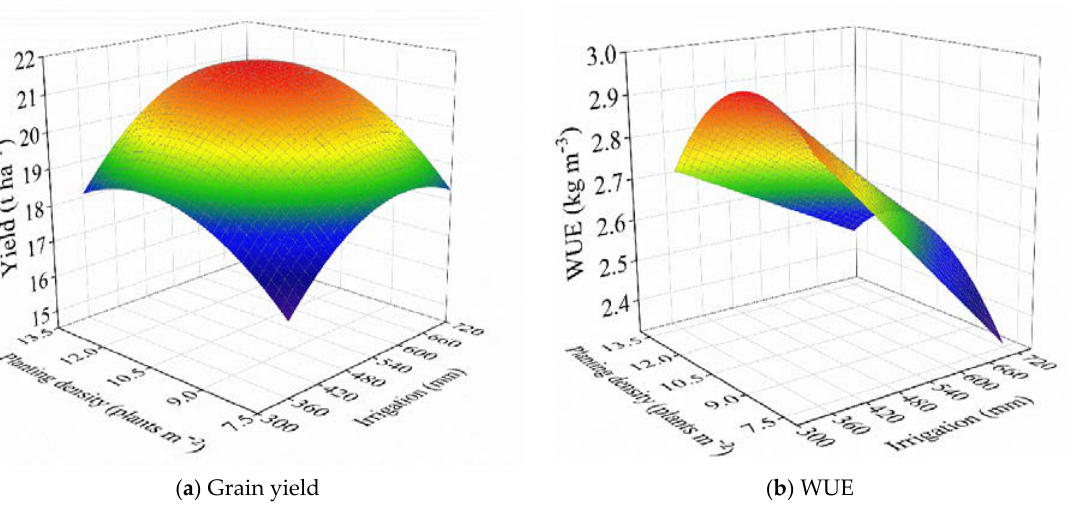
Figure 4. Relationship between grain yield ( a ) and water use efficiency ( b ) of maize under different irrigation and planting density treatments. WUE, water use